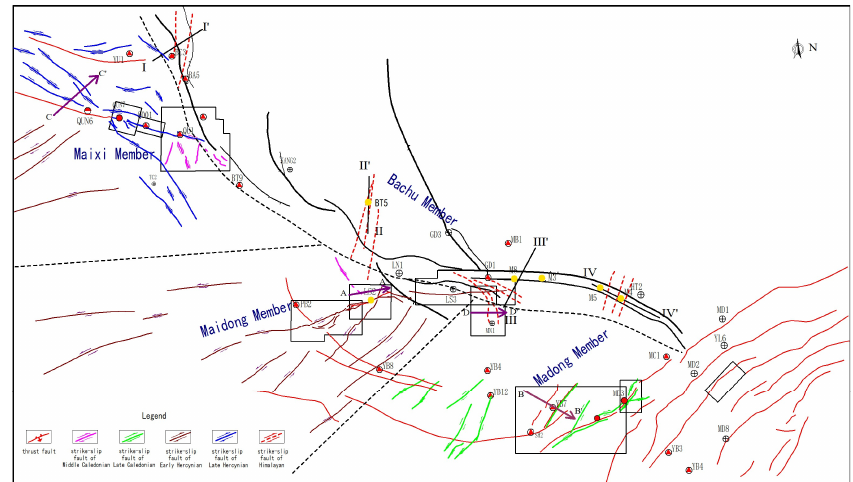
Figure 3. Fault pattern of the Maigaiti Slope.